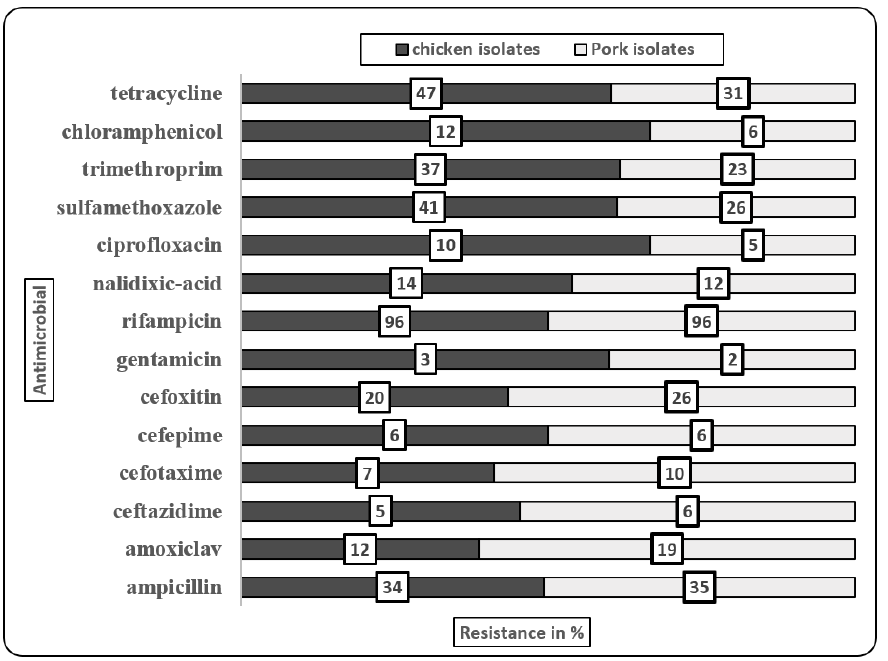
Figure 3. Figure showing the antimicrobial resistance profiles of chicken and pork isolates. The antimicrobial sensitivity testing is hinged on 268 chicken and 283 pork isolates.